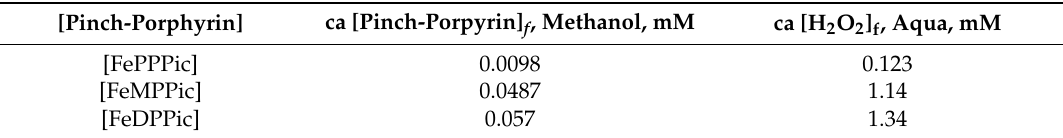
Table 4. Conditions of Compound I and II formation, starting of pinchporphyrins by spectroscopy